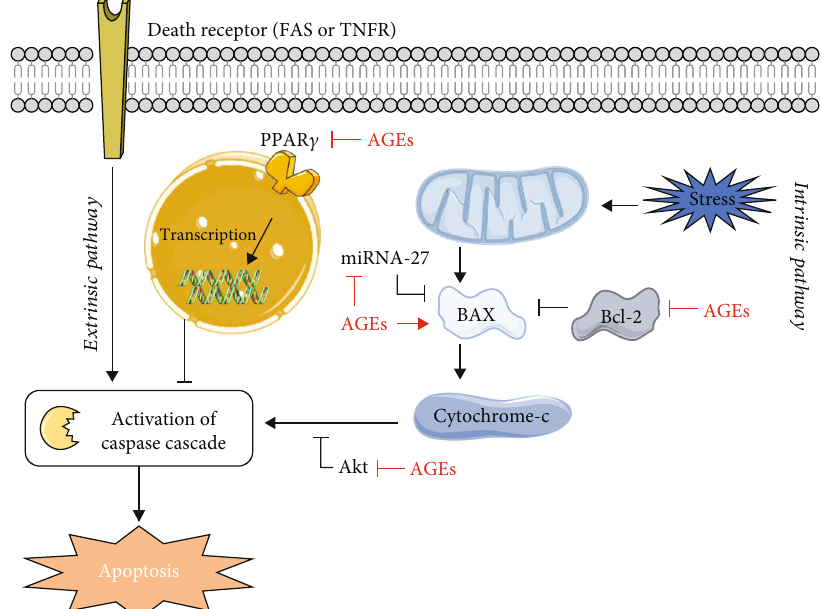
Figure 2: Interference of AGEs in the extrinsic and intrinsic apoptosis pathways. Via the extrinsic as well as intrinsic pathways, AGEs lead to an increase in apoptosis. AGEs release the blockage of PPAR γ on the caspase cascade. In addition, AGEs reduce the expression of miRNA-27 and Akt, increase the expression of BAX protein whereas the antiapoptotic Bcl-2 is inhibited, all resulting in an increase in apoptosis.